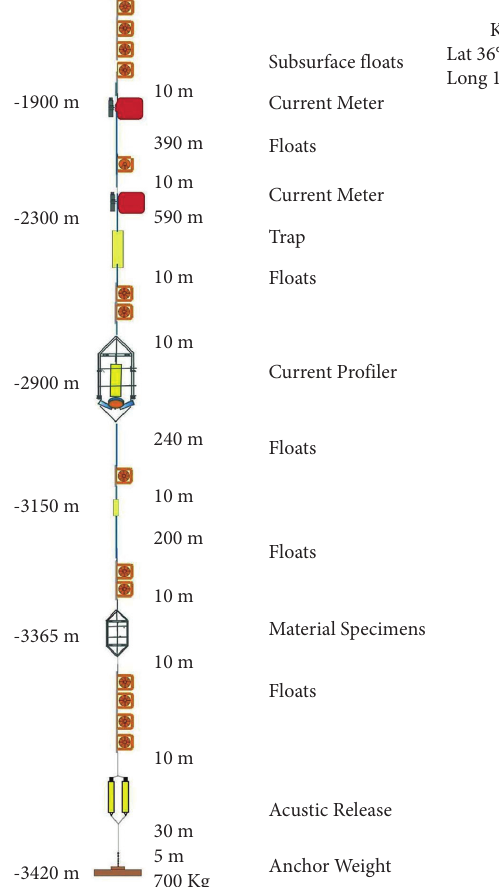
Figure 5: Outline of the KCL mooring line (from [11] located at the NEMO site).